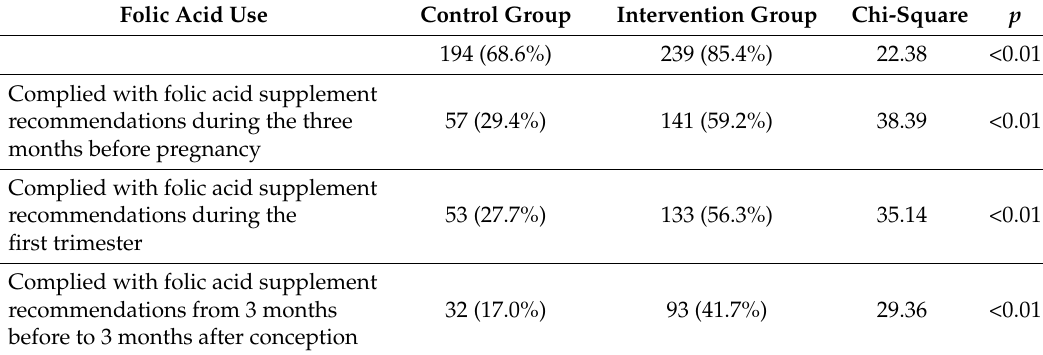
Table 3. Comparison of the intervention group with the control group regarding folic acid use among rural women after